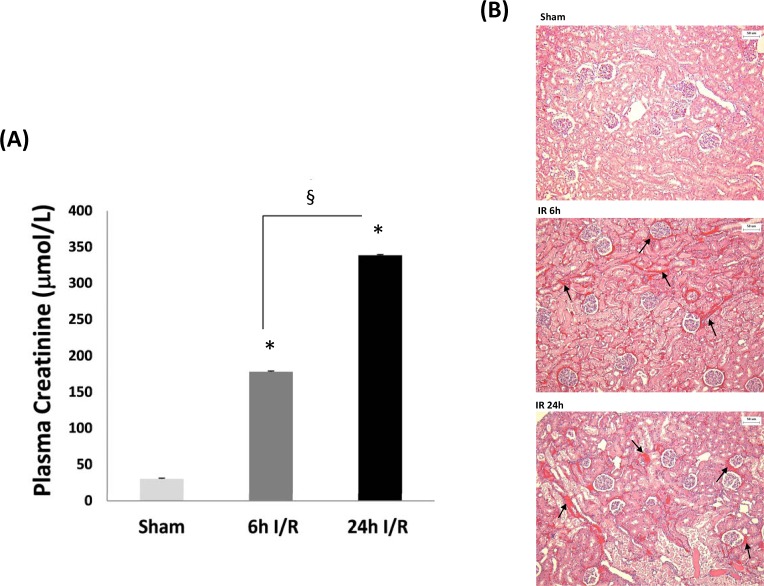
Markers of acute kidney injury measured in (A) plasma and (B) renal slices from sham, 6 and 24h I/R groups. (A) Plasma creatinine concentrations from sham, 6 and 24 hour I/R groups. Values are means ± SEM (n = 4 in each group). * Significant difference compared to sham, P<0.05. § Significant difference between I/R groups, P<0.05. (B) Hematoxylin and eosin (H&E) staining of renal tissue in sham, 6 and 24h I/R groups. The left kidney of rats was subjected to 45 min ischemia followed by 6h or 24h of reperfusion (I/R). As a control, rats were subjected to a sham-operation without inducing ischemia (Sham). The gross appearance of a mid-transverse plane of kidney was examined by H&E staining and analyzed at ×100 magnification. Kidneys in the I/R group followed by 6h or 24h of reperfusion (b and c) showed interstitial congestion (arrow) compared with the Sham group (a).